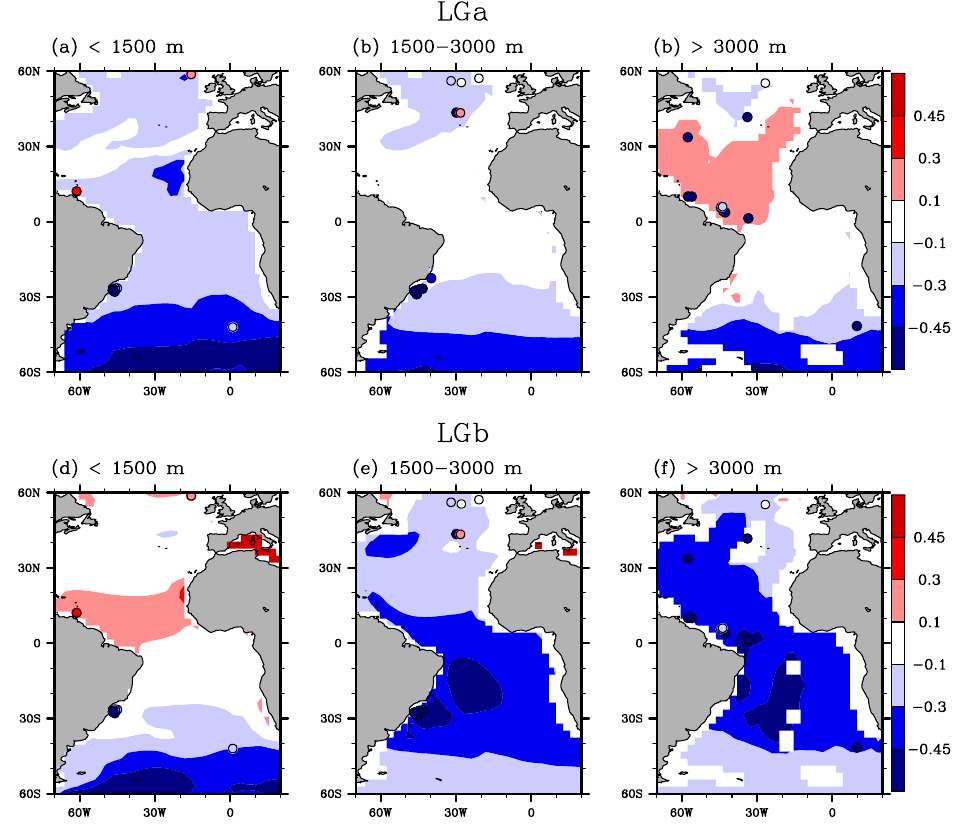
Fig. 6. (a – c) Atlantic δ 13 C anomaly (‰) between LGa and PIa, averaged upper 1500m depth, between 1500 and 3000m, and below 3000m. (d – f) as in (a – c) , but for between LGb and PIb. Circles are sediment core data (Curry and Oppo,